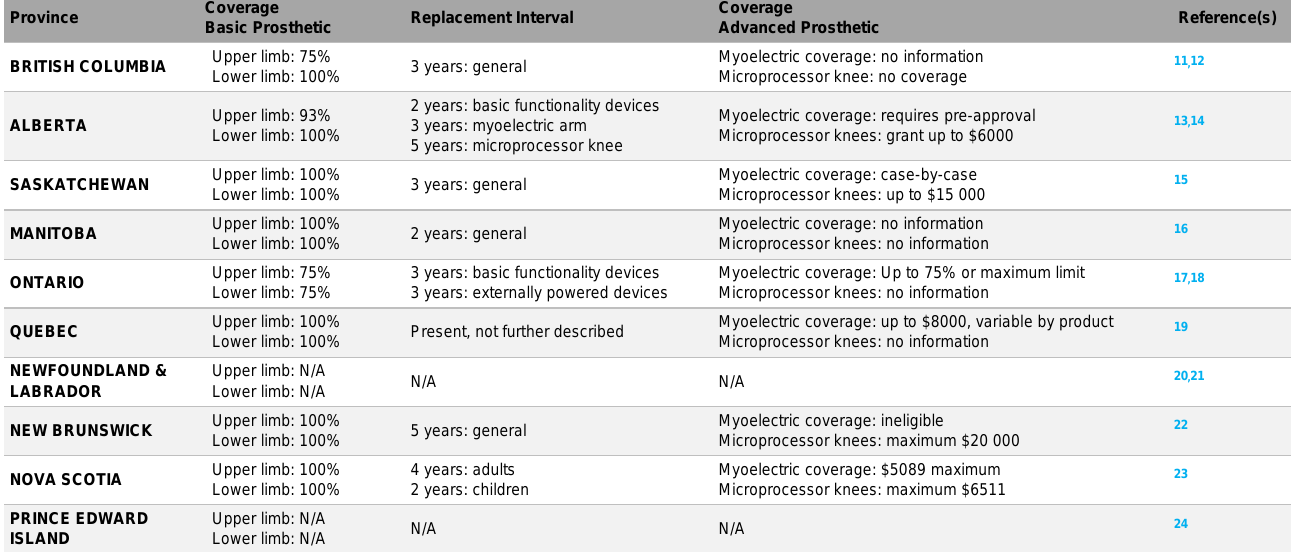
Table 2: Traits of prosthetic coverage across the provinces. Policy documents were reviewed and details are reported to the extent which they are reported in policy documents. Coverage is defined as a percentage covered according to policy and procedure list of a basic upper prosthetic component (Ergoarm 12K42, 4552$), and a basic lower prosthetic component (Ottobock 3R106, 1923$).